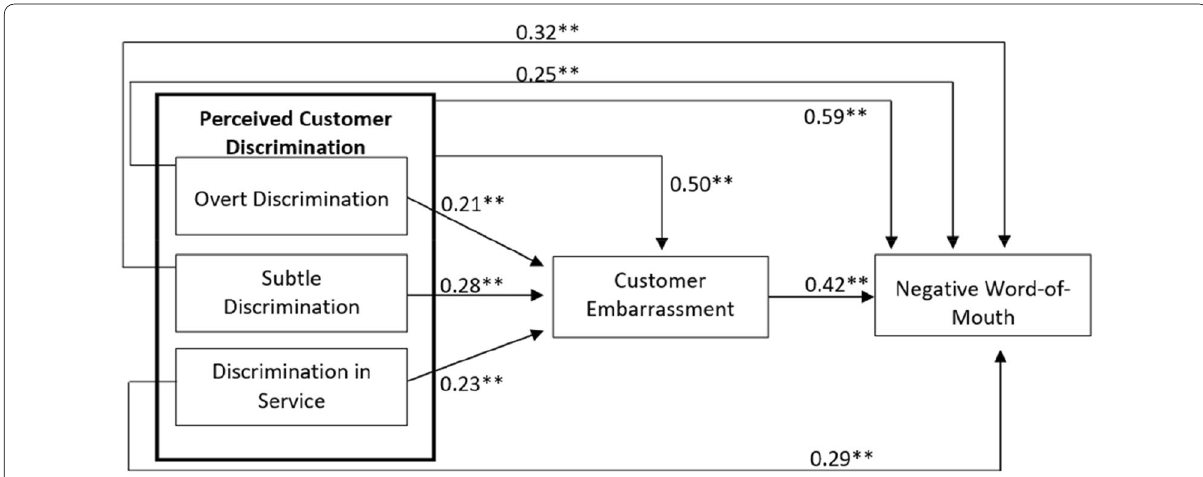
Fig. 2 Regression